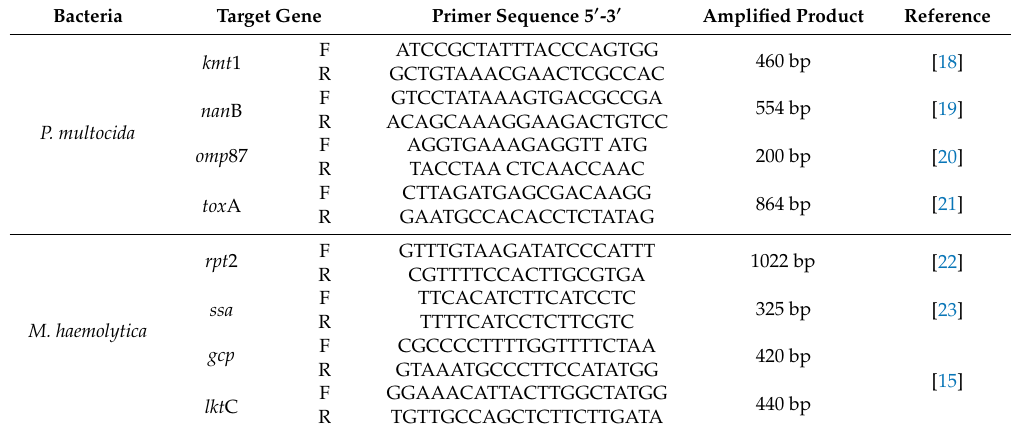
Table 2. Primers sequences and amplified products for the targeted genes for P. multocida and M. haemolytica isolates.